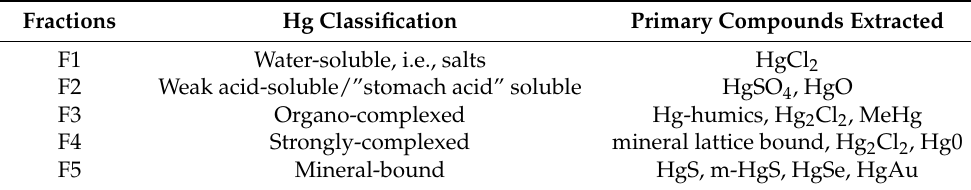
Table 3. Primary compounds are released with Bloom’s selective sequential extraction